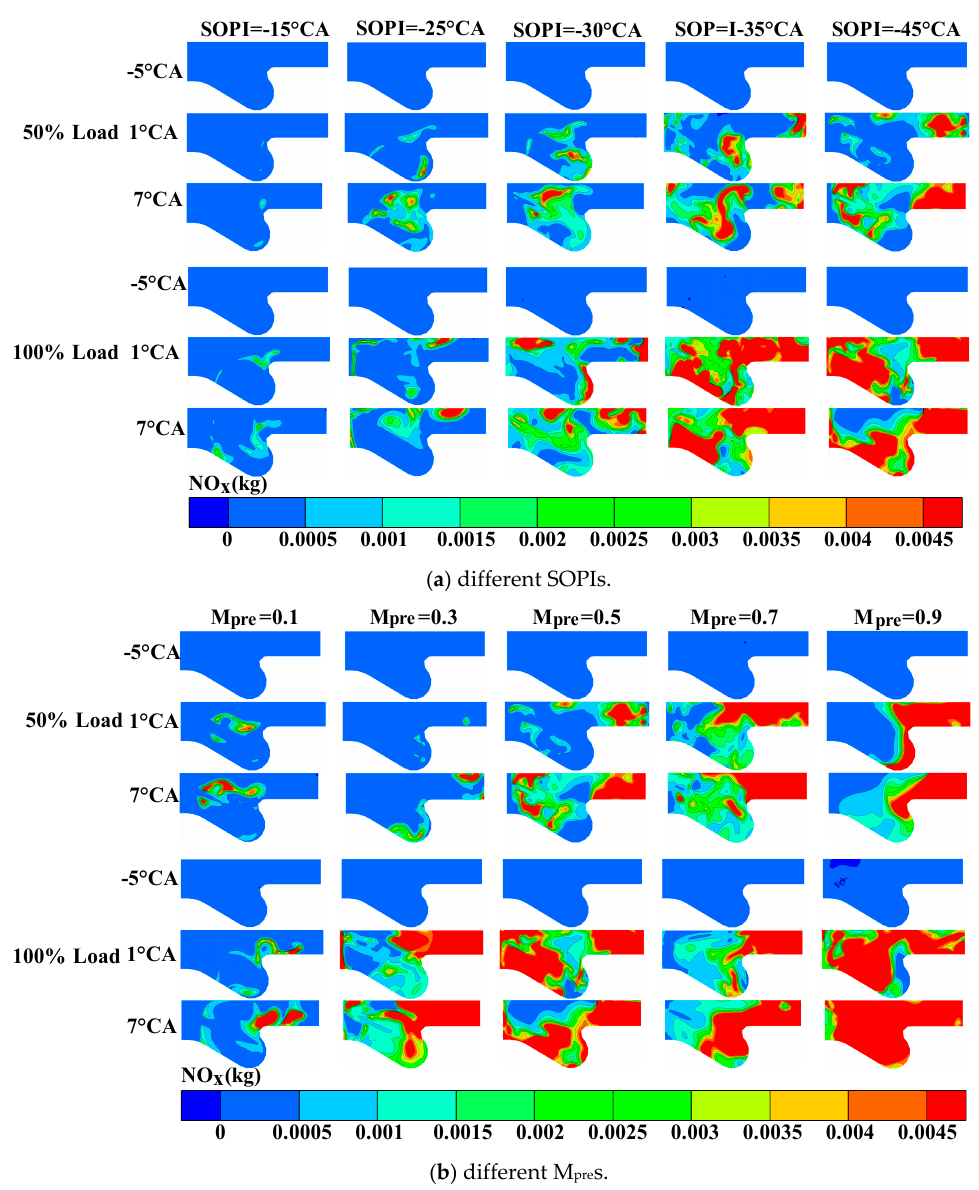
Figure 13. Comparison of NO x distribution field changes under different load conditions.